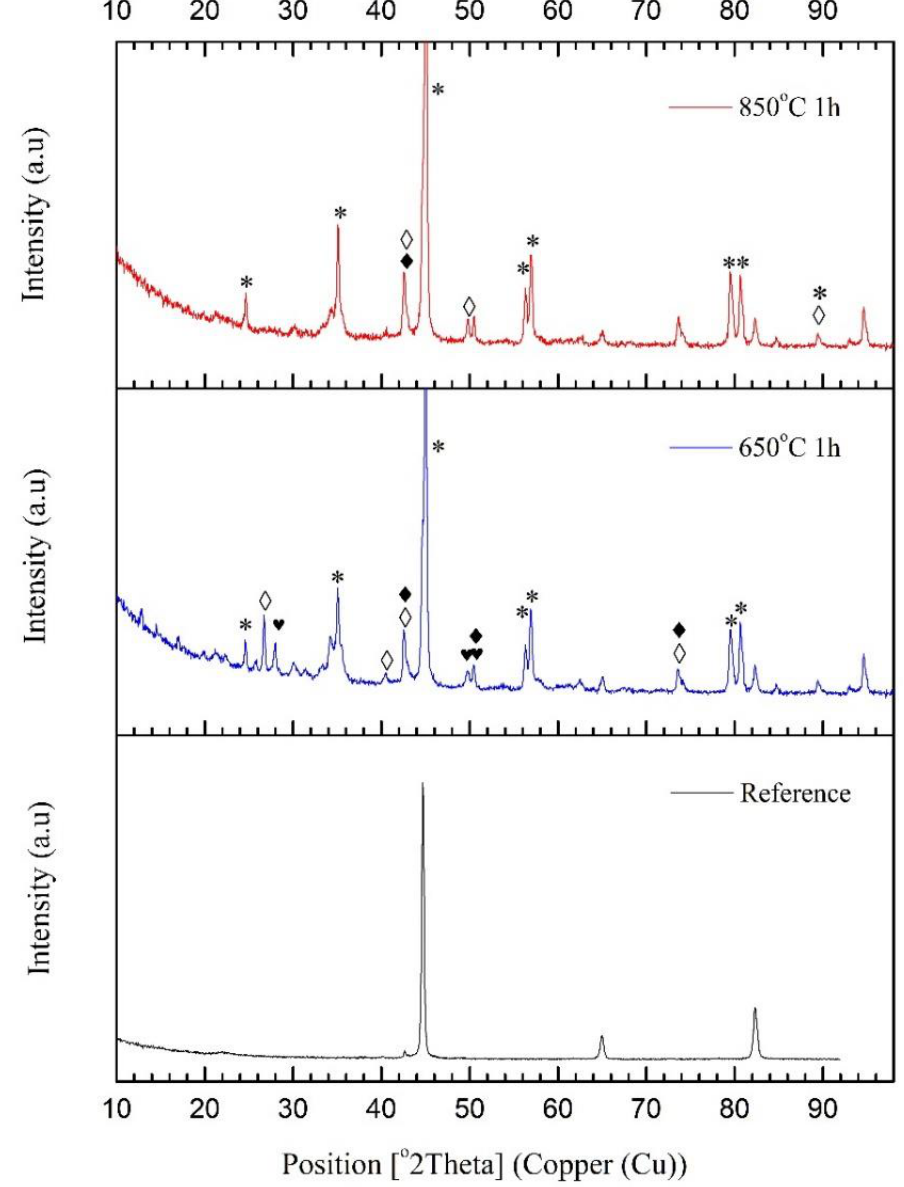
Figure 3. XRD patterns of the reference sample, together with the samples treated for 1 h in an N 2 atmosphere at different temperatures. ♦ —nanostructured h-BN phase; (cid:7) —a cubic (c-BN) phase; r —iron carbide (C 3 Fe 7 ); *—iron-boride phase, Fe 2 B.